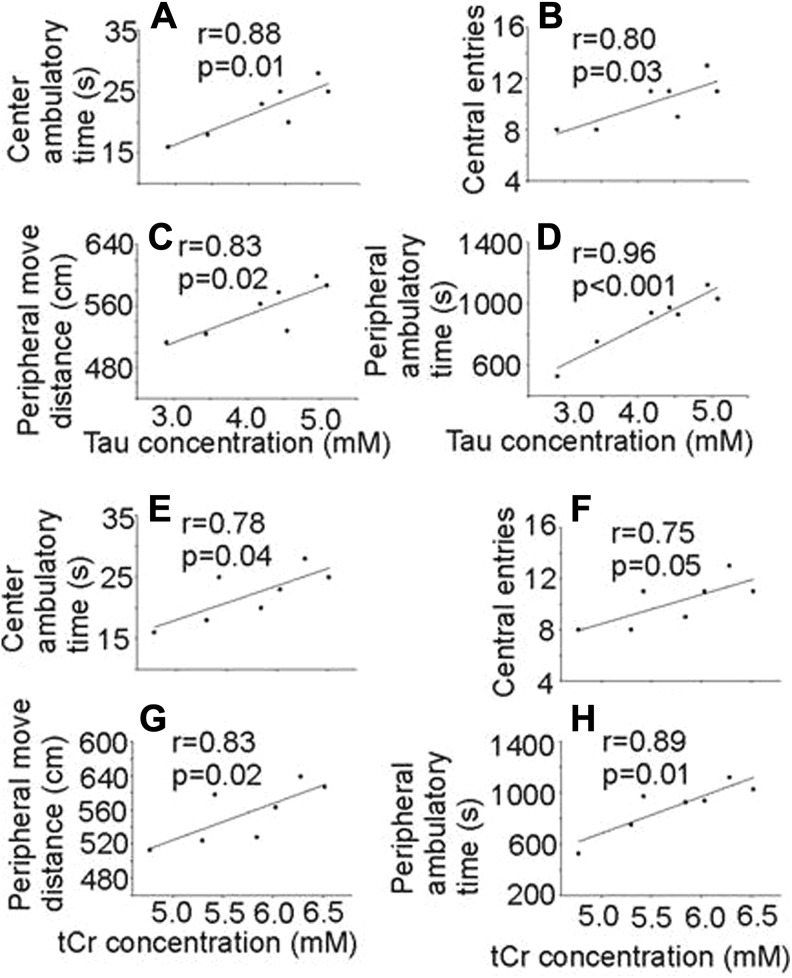
Correlation between thalamic Tau and tCr concentrations and OFT measurements. A-D, thalamic Tau and (E-H) thalamic tCr concentrations (mM). Data are presented as experiments from 7 animals. Cr indicates creatine; OFT, open field test; r, Pearson correlation coefficient; tCr (total creatine), Cr + PCr (phosphocreatine); Tau, taurine.